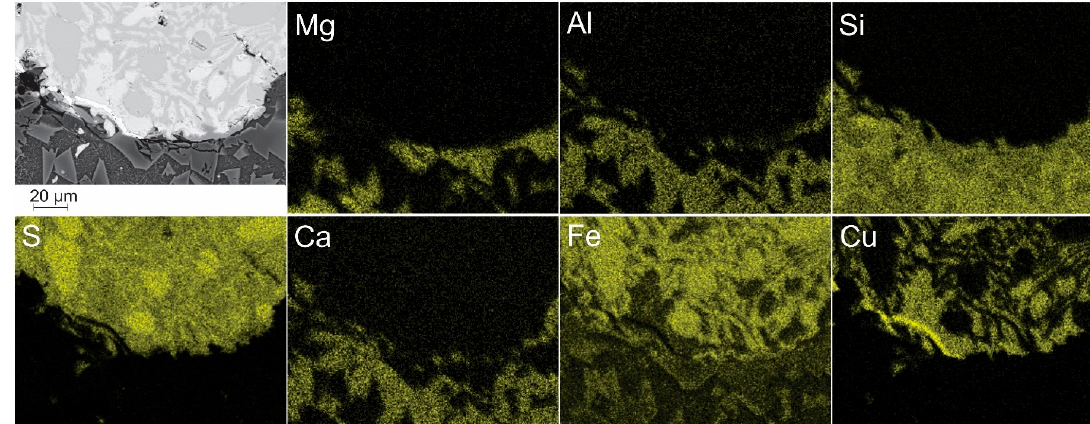
Figure 7. SEM-EDS maps displaying the elemental abundance in the area displayed in Figure 6. First image is SEM-BSE. Areas rich in Al, Ca and Si correspond to the amorphous matrix. High brightness in Cu map is elemental copper and medium brightness is bornite.